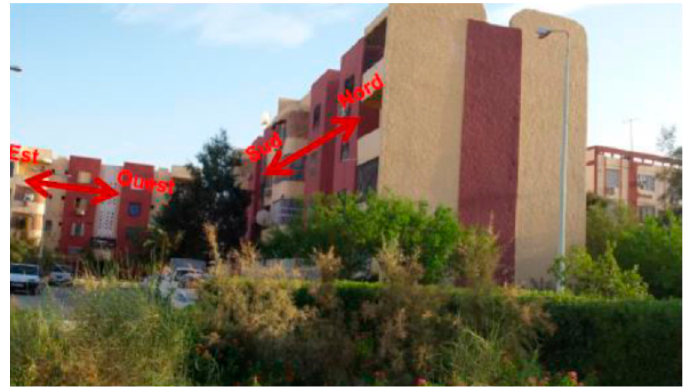
Figure 3. Residential buildings built in the 1980s.